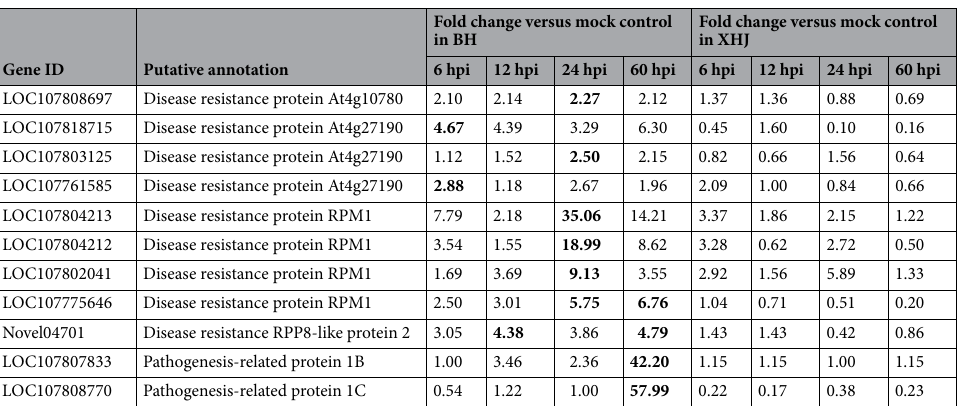
Table 3. Key disease resistance proteins and pathogenesis-related proteins significantly induced in BH. The gene expression data at 6, 12, 24, and 60 hpi were compared to data in mock-infected control and the fold change is demonstrated.